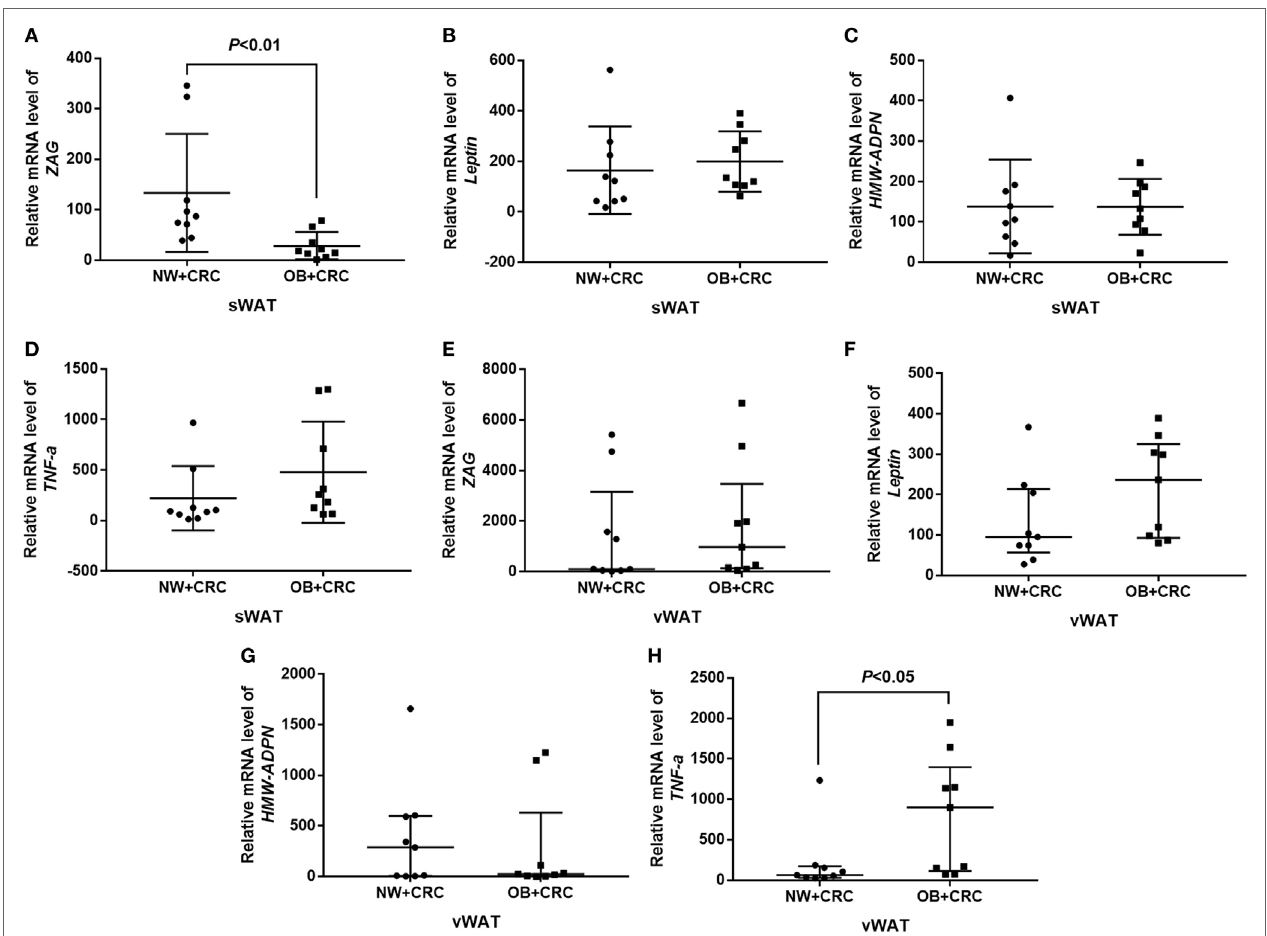
FigUre 2 | ZAG, leptin, HMW-ADPN, and TNF- α mRNA levels in sWAT (a–D) and vWAT (e–h) of NW + CRC and OB + CRC patients. Abbreviations: ZAG, zinc- α 2-glycoprotein; HMW-ADPN, high-molecular-weight-adiponectin; TNF- α , tumor necrosis factor-alpha; sWAT, subcutaneous white adipose tissue; vWAT, visceral white adipose tissue; NW, normal weight; OB, obese; CRC, colorectal cancer. All values are expressed as the median with the interquartile